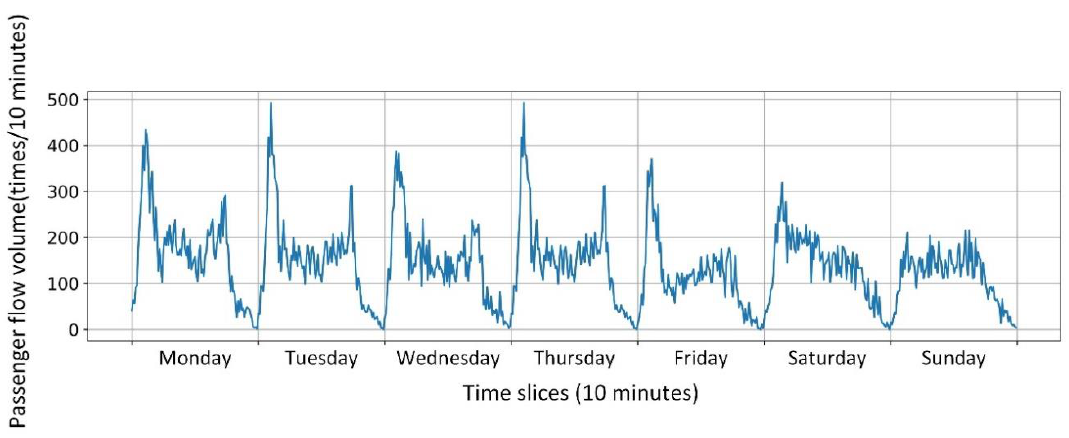
Figure 8. Time series plot of passenger flow, 7‒13 March 2016, Licun Park.